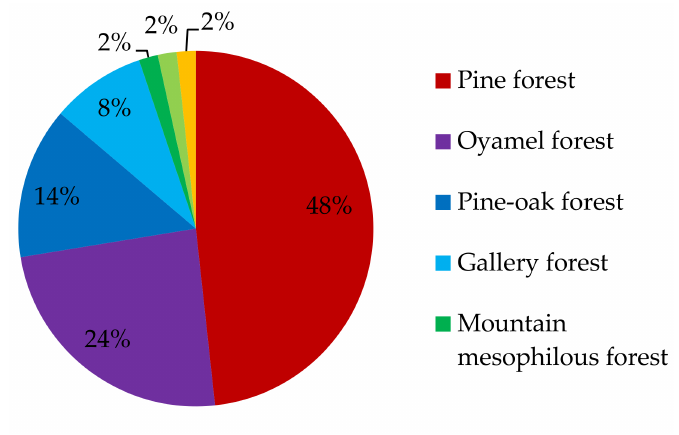
Figure 2. Percentages of studies classified according to the type of ecosystem following the classification of the National Institute of Statistics and Geography